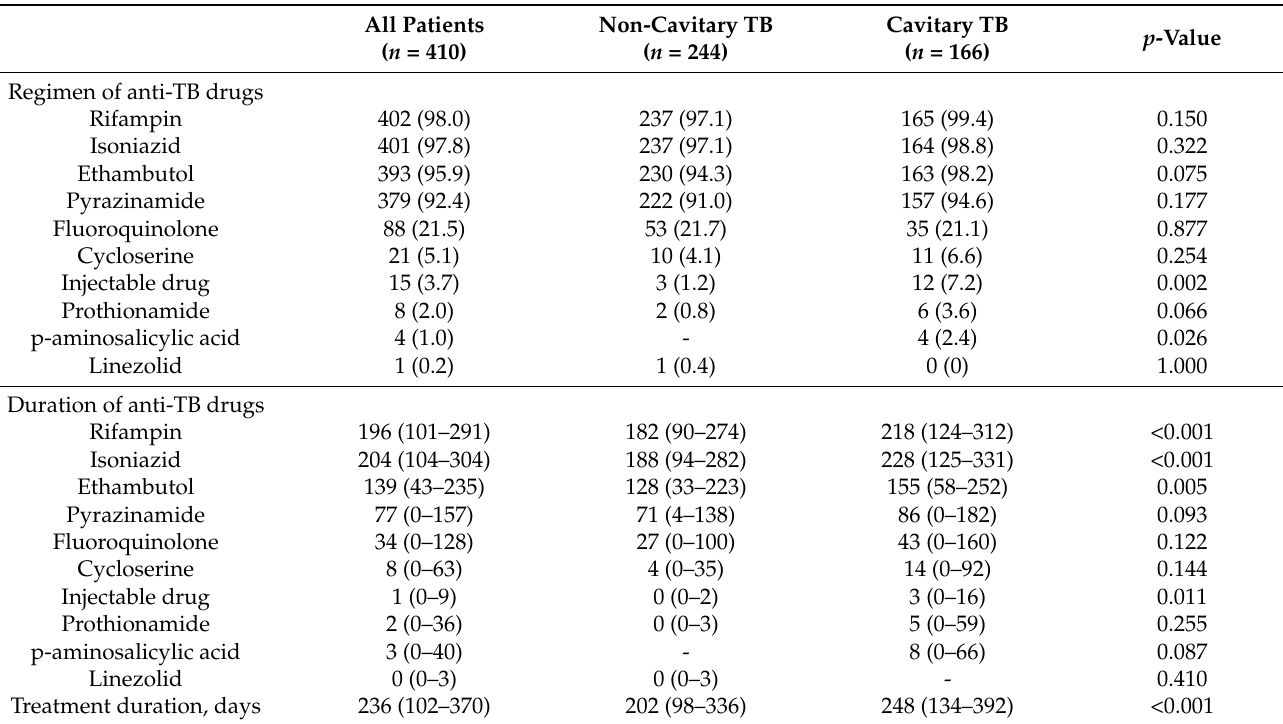
Table 3. Treatment regimens and durations for patients with cavitary and non-cavitary TB.